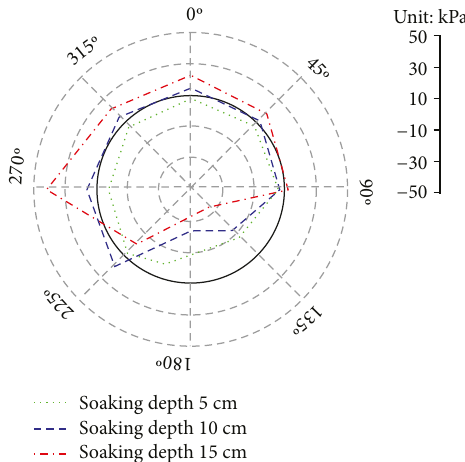
Figure 9: Soil pressure of half-range soaking in fi nal